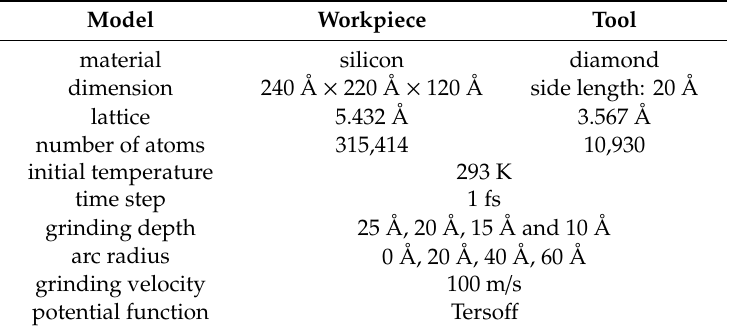
Figure 1. MD simulation setup: ( a ) 3D model; ( b ) movement trajectory design of the diamond tool during grinding; ( c ) schematic diagram of the unit cell of monocrystalline silicon. Table 1. MD simulation parameters.